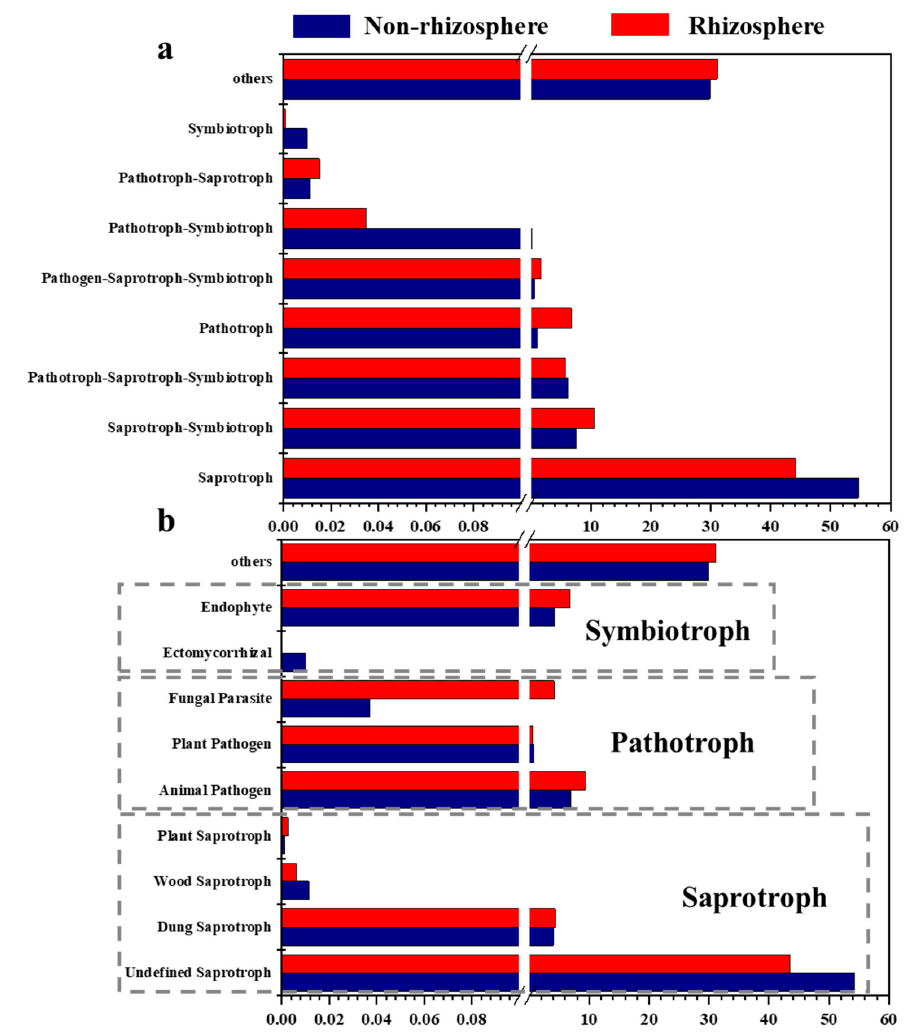
Figure 4. The abundance of di ff erent functional roles ( a ) and main guilds ( b ) assigned to the fungal community using FUNGuild.